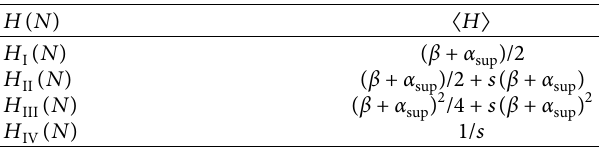
Table 4: Average factors for various interspecific models of sterile- fertile